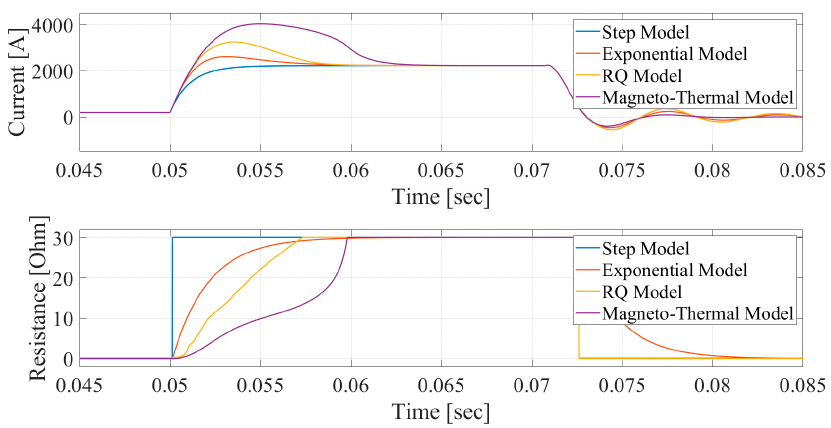
Figure 15. Model comparison for 400 A critical current and 5 Ω fault resistance.